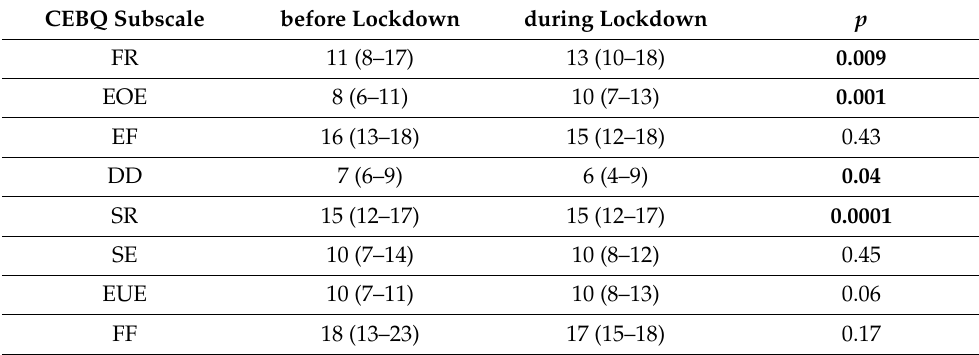
Table 2. Differences in CEBQ subscale before and during lockdown.